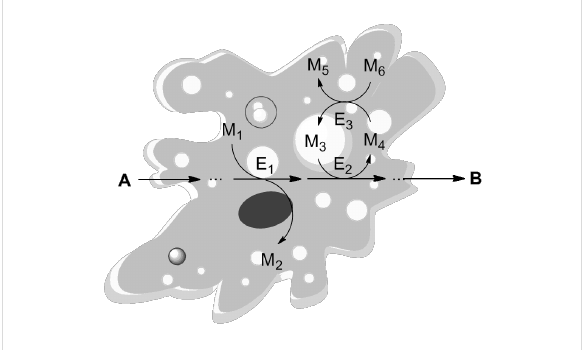
Figure 1: Metabolic pathways in a living cell as an example of efficient coupled-reaction processes. A: Substrate; B: Product; E 1–3 : Enzymes; M 1–6 :